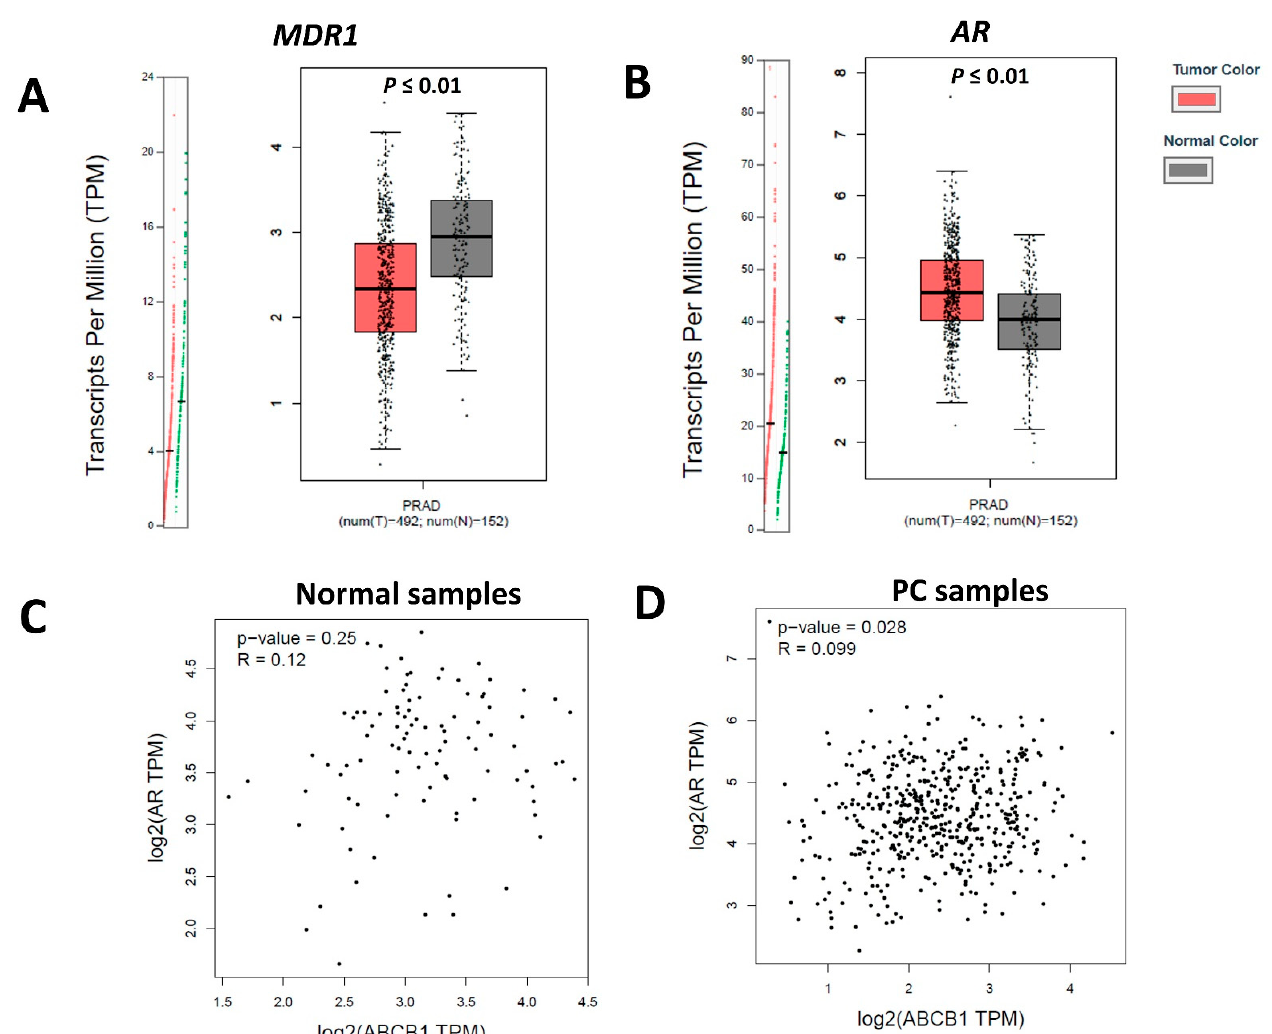
Figure 6. MDR1 and AR transcriptional evaluation on human prostate samples. ( A ): Higher MDR1 gene expression in normal prostatic samples compared to prostate cancer (PC) samples. The normal samples demonstrate higher transcripts per million (TPM) (green dots) than PC (red dots). ( B ): AR gene expression in normal prostate and PC cases. Higher AR expression on PC samples is observed. The normal samples demonstrate lower TPM (green dots) than PC (red dots). ( C ): Correlation analysis between MDR1 and AR gene expression in normal prostatic samples showing no association. ( D ): Positive low correlation between MDR1 and AR transcripts on human PC samples. The gene expression dotplot is generated using the GEPIA database (http://gepia.cancer-pku.cn/about.html, accessed on 16 November 2021). PRAD: PC dataset.